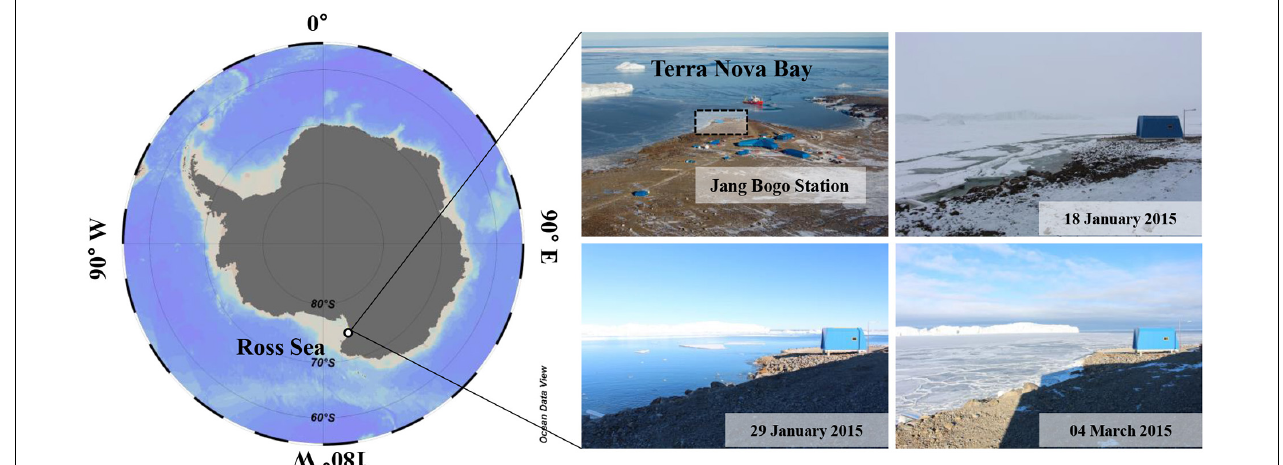
FIGURE 1 | Study area and photos for the sampling station at JBS, 2015. A dashed box is a sampling location in our